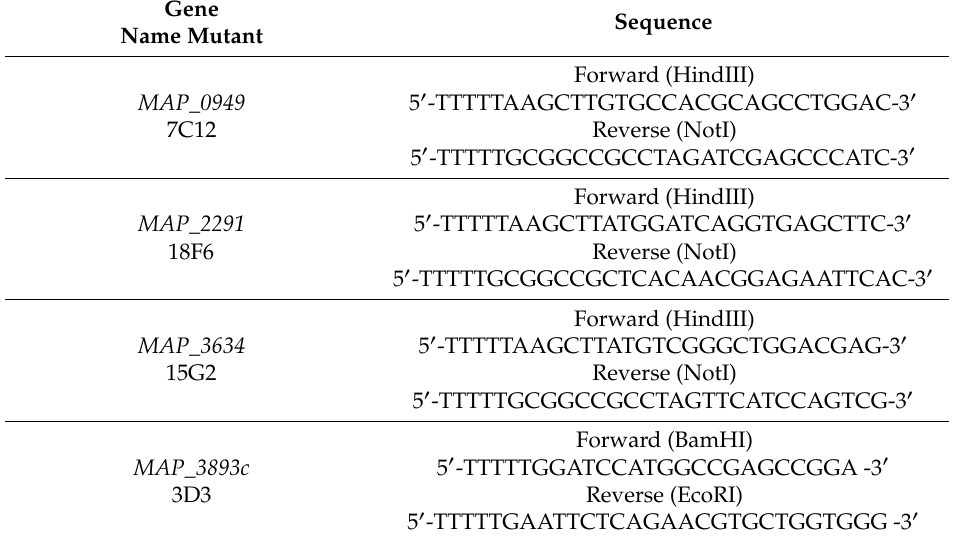
Primers used to complement Mycobacterium avium subsp. paratuberculosis (MAP) transposon mutants. Gene Name